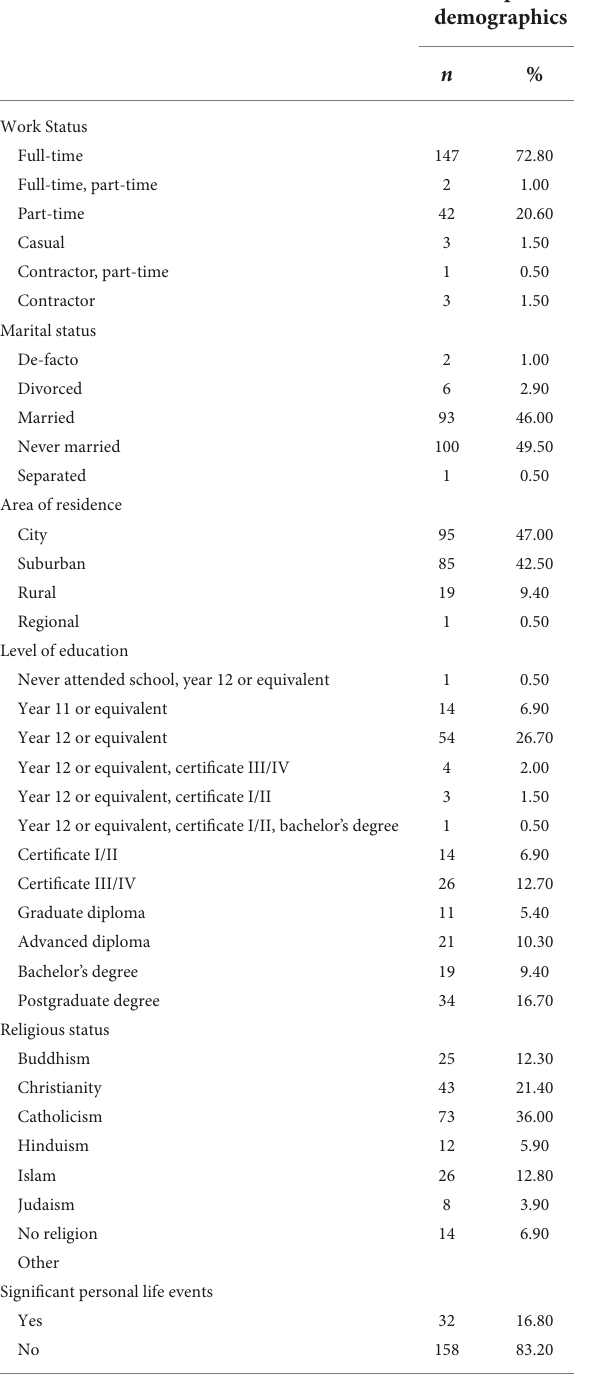
TABLE 1 General demographic information of participants. TABLE 2 Descriptive statistics about participants volunteer involvement and COVID-19